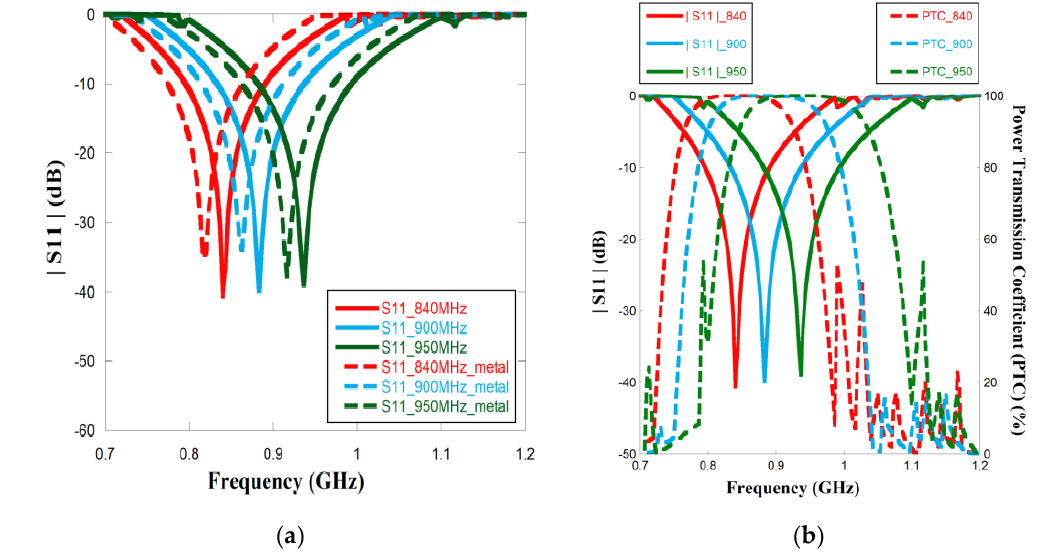
Figure 3. ( a ) Compared results of | S 11| of metal vs without metal; ( b ) | S 11| and PTC results for three frequencies. Table 2. Comparison Results of Switching Conditions between Metal and Non - Metal.